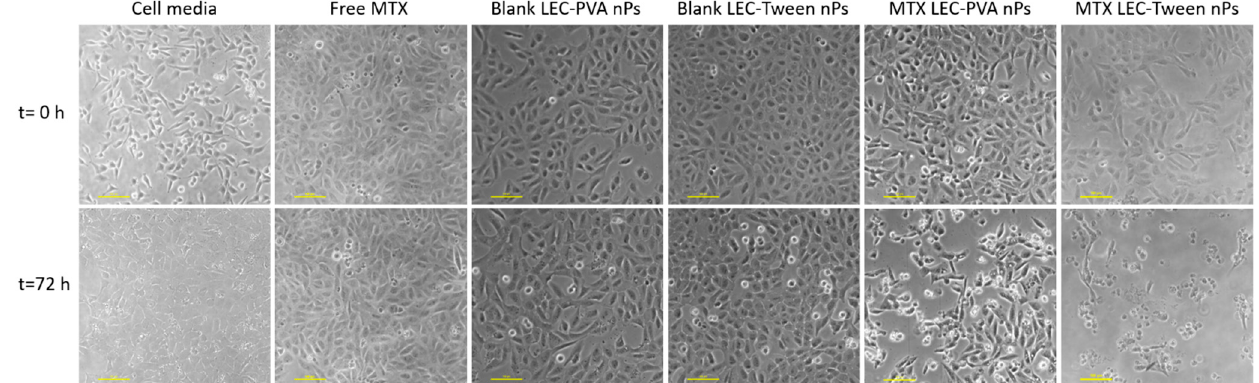
Figure 6. Cell viability difference between the beginning of the experiments and after 72-h of treatment recirculation, being the drug concentration of 15 μ M and the microfluidic platform used of a height of 100 μ m. Cells under media recirculation grow reaching high confluence. Free ‐ MTX and blank nanoparticles have a cytostatic effect over cell viability, whereas MTX ‐ loaded nanoparticles have a cytotoxic effect, reducing cell population. Scale bar: 100 μ m.